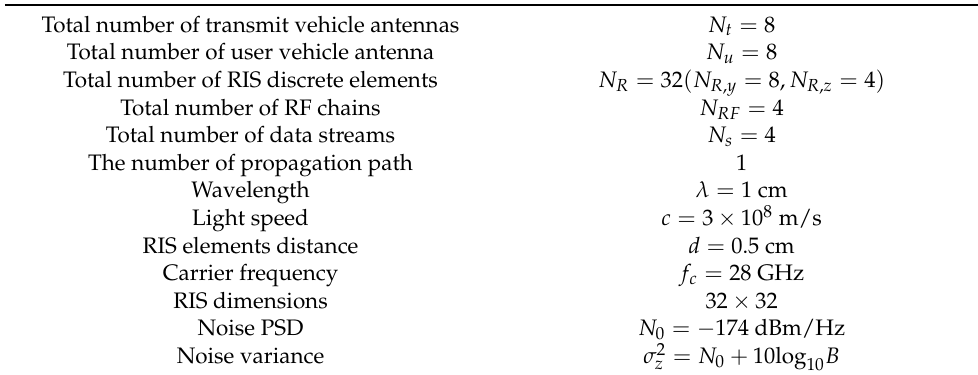
Table 1. Simulation